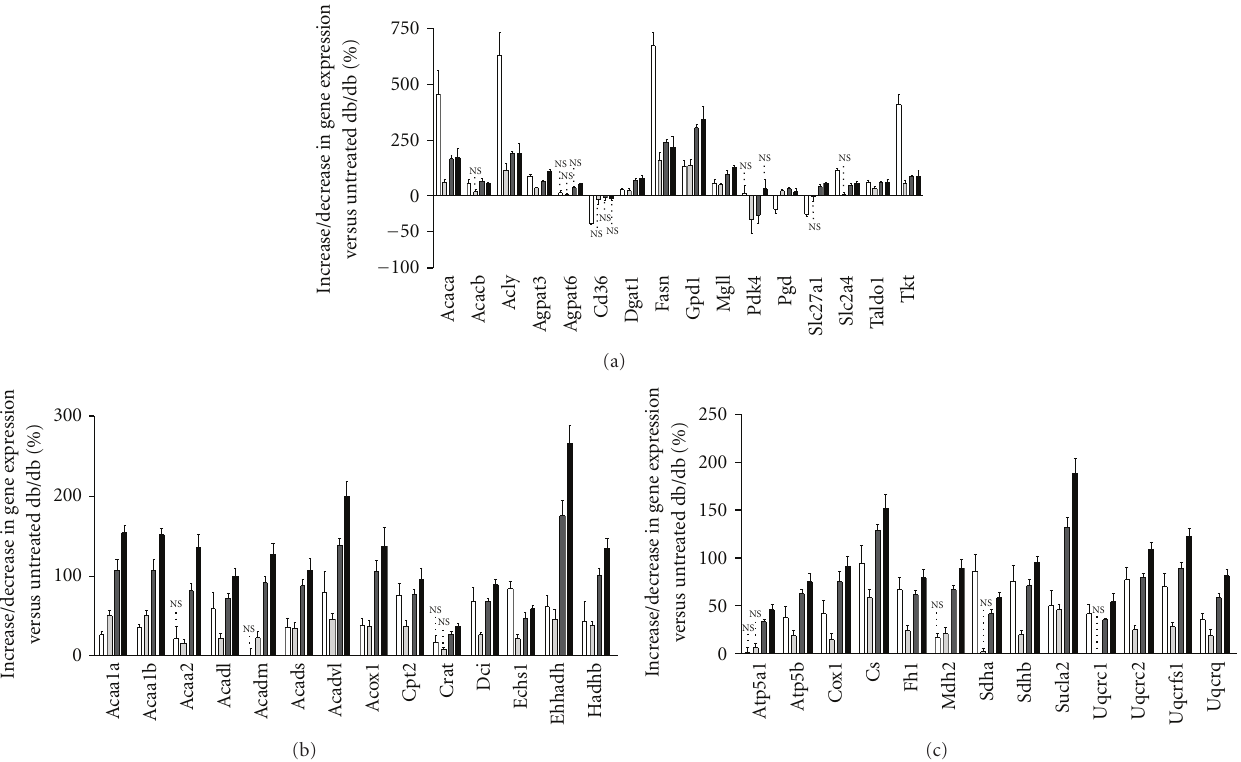
Figure 4: Expression profiles of key genes involved in IAT FA metabolism. Di ff erentially expressed genes in db/+ (the white square) as well as 10 (the o ff -white square), 30 (the grey square), and 100 (the black square) mg/kg RSG-treated db/db mice were measured versus untreated db/db and plotted as the mean (% increase/decrease of db/db control) ± SEM ( n = 6). NS; P ≥ . 001 otherwise P < . 001 . (a) Genes related to FA transport, glucose, FA and TG synthesis and pentose pathway ∗ : Agpat3, 1-acylglycerol-3-phosphate O-acyltransferase 3; Dgat1, diacylglycerol O-acyltransferase 1; Slc27a1, solute carrier family 27 (fatty acid transporter), member 1; Slc2a4, solute carrier family 2 (facilitated glucose transporter), member 4. (b) Genes related to mitochondrial and peroxisomal β -oxidation: Acaa1a, Acaa1b, acetyl-Coenzyme A acyltransferase 1A, 1B; Acaa2, acetyl-Coenzyme A acyltransferase 2; Acadl, acyl-Coenzyme A dehydrogenase, long chain; Acadm, acyl-Coenzyme A dehydrogenase, medium chain; Acads, acyl-Coenzyme A dehydrogenase, short chain; Acadvl, acyl- Coenzyme A dehydrogenase, very long chain; Acox1, acyl-Coenzyme A oxidase 1, palmitoyl; Cpt2, carnitine palmitoyltransferase 2; Crat, carnitine acetyltransferase; Dci, dodecenoyl-Coenzyme A delta isomerase (3,2 trans-enoyl-Coenzyme A isomerase); Echs1, enoyl-Coenzyme A hydratase, short chain 1 mitochondrial; Ehhadh, enoyl-Coenzyme A, hydratase/3-hydroxyacyl-Coenzyme A dehydrogenase; Hadhb, hydroxyacyl-Coenzyme A dehydrogenase/3-ketoacyl-Coenzyme A thiolase/enoyl-Coenzyme A hydratase, beta subunit. (c) Genes related to citrate metabolism and oxidative phosphorylation: Atp5a1, ATP synthase, H+ transporting, mitochondrial F1 complex, alpha subunit, isoform 1; Atp5b, ATP synthase, H+ transporting mitochondrial F1 complex, beta subunit; Cox1, M. musculus mRNA for mitochondrial gene for subunit I of cytochrome c oxidase; Cs, citrate synthase; Fh1, fumarate hydratase 1; Mdh2, malate dehydrogenase 2, NAD (mitochondrial); Sdha, succinate dehydrogenase complex, subunit A, flavoprotein (Fp); Sdhb, succinate dehydrogenase complex, subunit B, iron sulfur (Ip); Sucla2, succinate-Coenzyme A ligase, ADP-forming, beta subunit; Uqcrc1, Uqcrc 2, ubiquinol-cytochrome c reductase core protein 1, 2; Uqcrfs1, ubiquinol-cytochrome c reductase, Rieske iron-sulfur polypeptide 1; Uqcrq, ubiquinol-cytochrome c reductase, complex III subunit VII. ∗ gene abbreviations given in Figure 1 were not